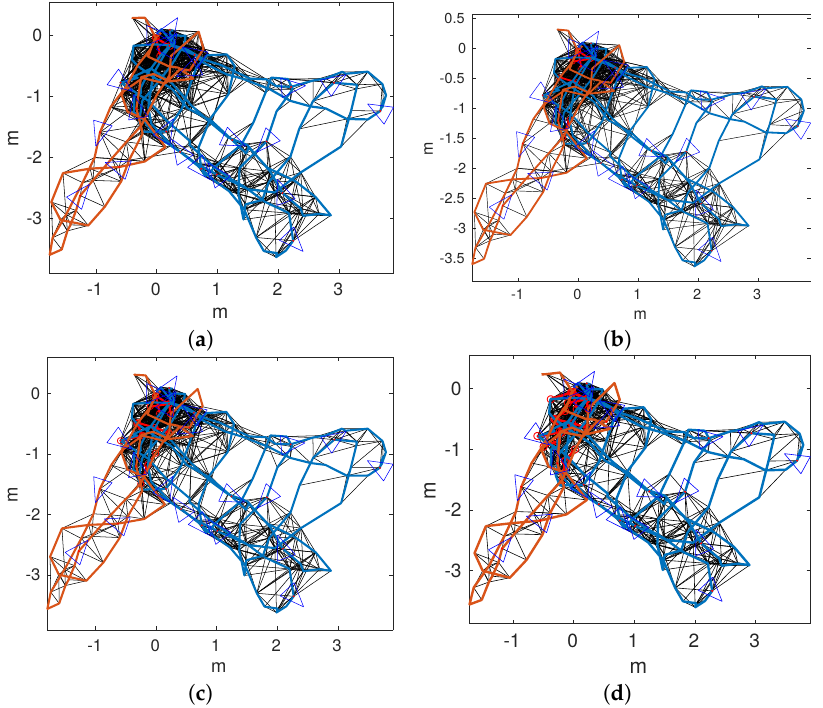
Figure 15. Obtained trajectories for V 3 and V 4: ( a ) MSLAM1, ( b ) MSLAM5, ( c ) MSLAM10, and ( d ) MSLAM15. In SLAM, thick lines are the trajectories, thin lines are the detected loops, and the triangles show the estimated AUV